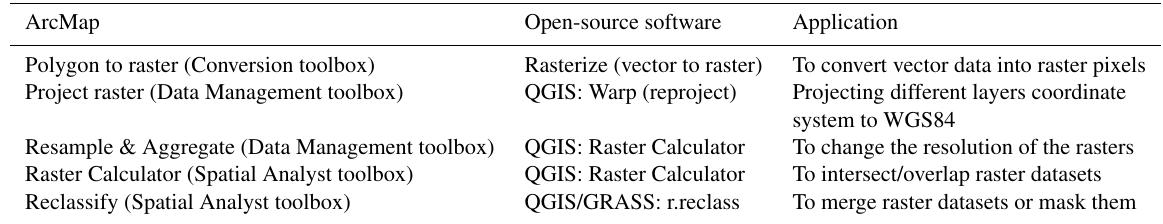
Table 3. ArcMap tools used in this study for data processing and their equivalent open-source software. ArcMap Open-source software Application Polygon to raster (Conversion toolbox) Rasterize (vector to raster) Project raster (Data Management